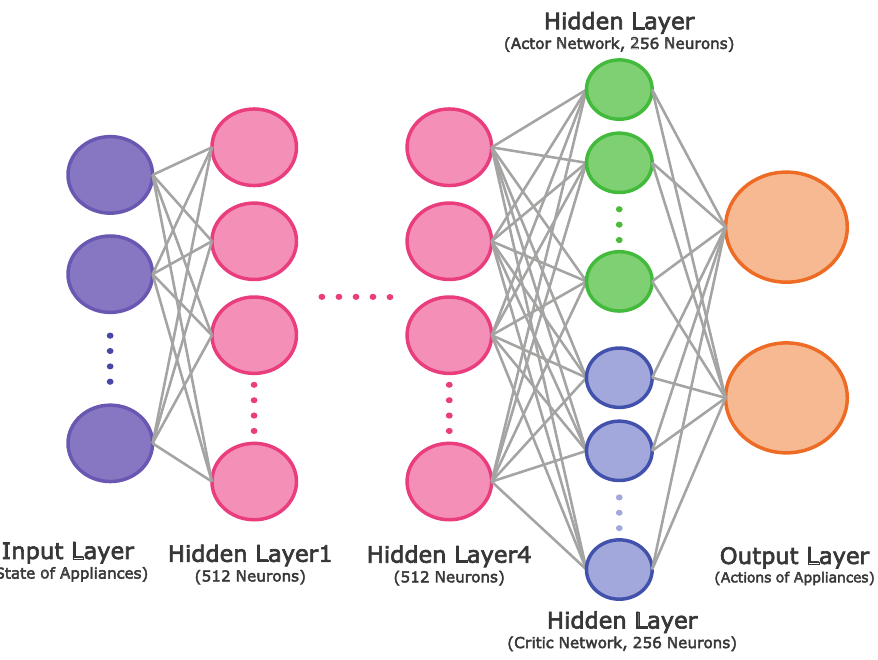
Figure 2. Architecture of the neural network model for the proposed actor–critic method. Algorithm 3: Proposed actor–critic-based energy management of smart home at level 1 (or level